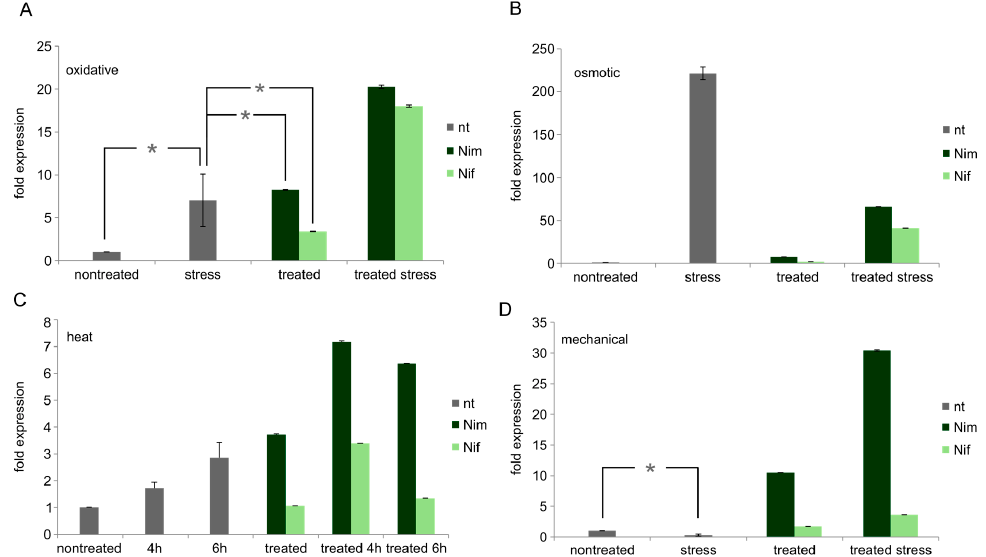
Figure 3. Fatty acid 2 hydroxylase (FA2H) mRNA levels in undifferentiated Neuro2a cells.